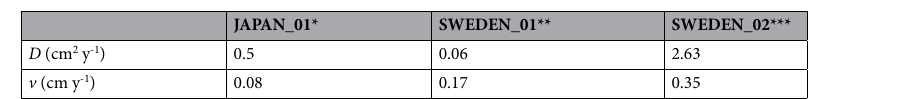
Table 2. Parameter settings for the three types of soil (JAPAN_01, SWEDEN_01 and SWEDEN_02) in terms of radiocesium migration parameters D and v in Eq. (3). *Based on soil sample data collected outside Fukushima Dai-ichi in April 2016, as presented in 26 . **Based on the selection of parameter settings for the site “Stenungsund” in Sweden, as presented in 17 . ***Based on the upper end value of observed D and values in Sweden as presented in 17